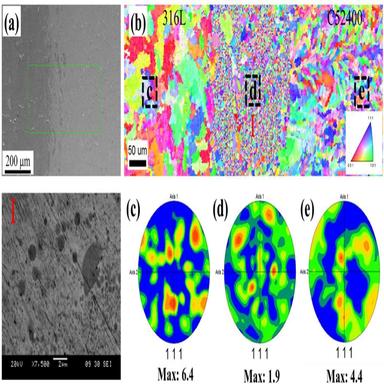
SEM and EBSD images at the SLMed C/L interface: (a) Testing region; (b) EBSD result; (c)(d)(e) Pole figures and (I): Microstructure after polishing corresponding to (b).